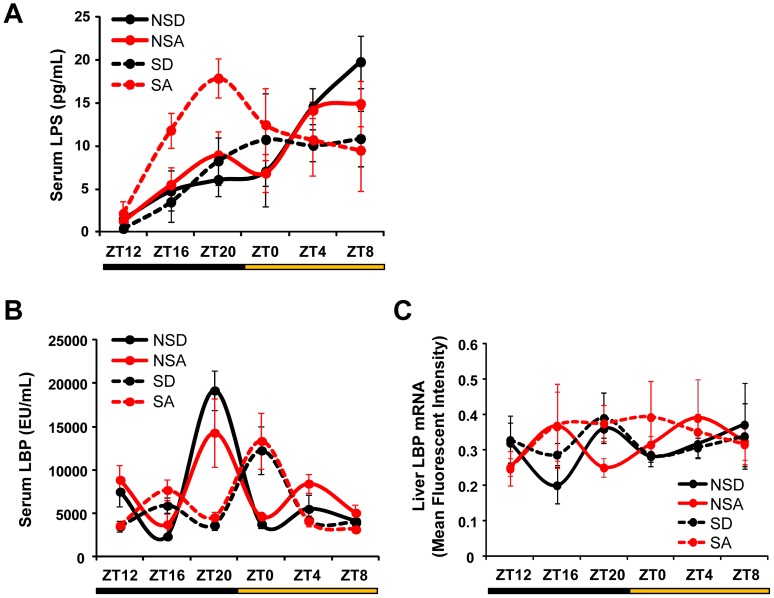
Environmental disruption of circadian organization impacts serum LPS and LBP levels.(A) Serum LPS levels exhibited a significant time-of-day effect (p<0.001), with a significant schedule (i.e., shifted vs. non-shifted) × time-of-day interaction (p<0.01). Three-way ANOVA. (B) There was an apparent delayed peak in serum LBP of shifted mice, independent of diet, that failed to reach statistical significance. (C) LBP mRNA expression in liver was not significantly affected by schedule or alcohol.